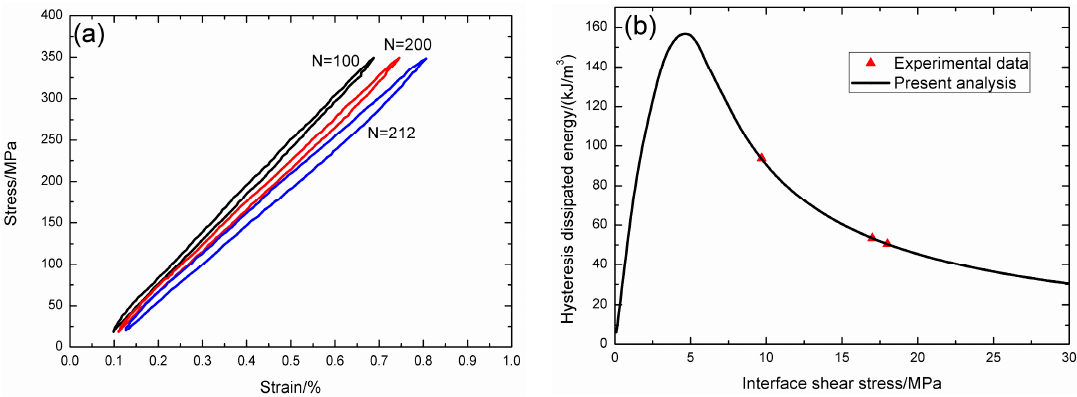
Figure 11. ( a ) The experimental fatigue hysteresis loops corresponding to different cycle number; and ( b ) the experimental and theoretical fatigue hysteresis dissipated energy versus interface shear stress curve of 2D woven C/SiC composite under σ max = 350 MPa at 550 °C in air. Table 6. The interface shear stress of 2D woven C/SiC composite corresponding to different applied cycles under fatigue peak stress of σ max = 350 MPa at 550 °C in air. Cycle Number Experimental Hysteresis Dissipated Energy/(kJ/m 3 ) Interface Shear Stress/MPa 100 50.5 100